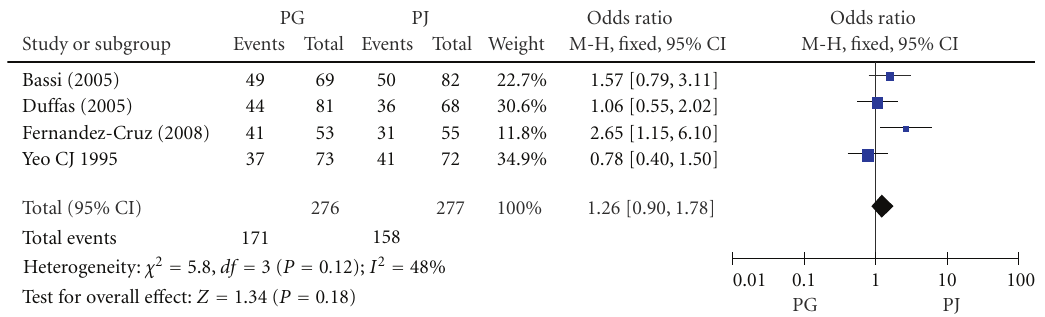
Figure 5: Forest plot of recovery with no complications between PG and PJ.